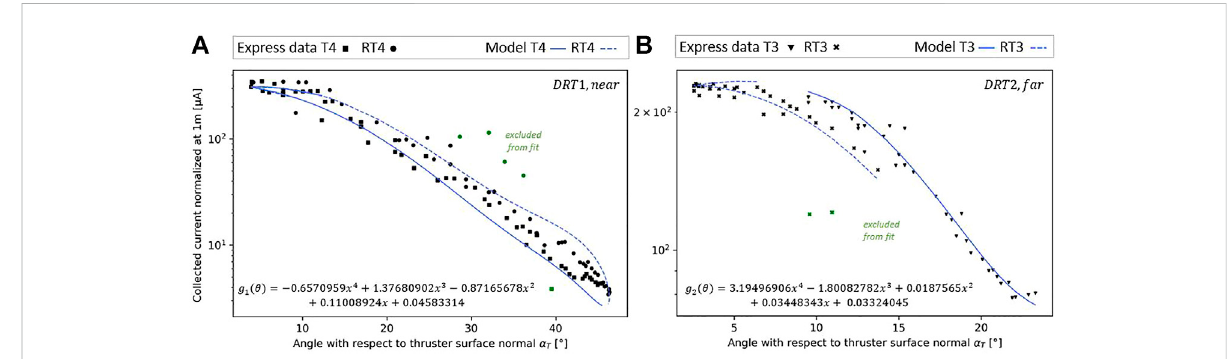
FIGURE 13 Collected current normalized at 1 m from the thruster exit as a function of the fi ring angle. Comparison of the processed Express-A data and model results. (A) Near probe and (B) far probe. The input IEDF is a shifted Maxwellian distribution for energy ( ε s (cid:2) 250eV , T i = 0.2 eV) and a fi tted angular function g ( θ )